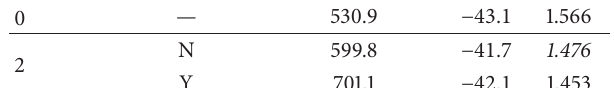
Figure 8: Samples for DMA test.